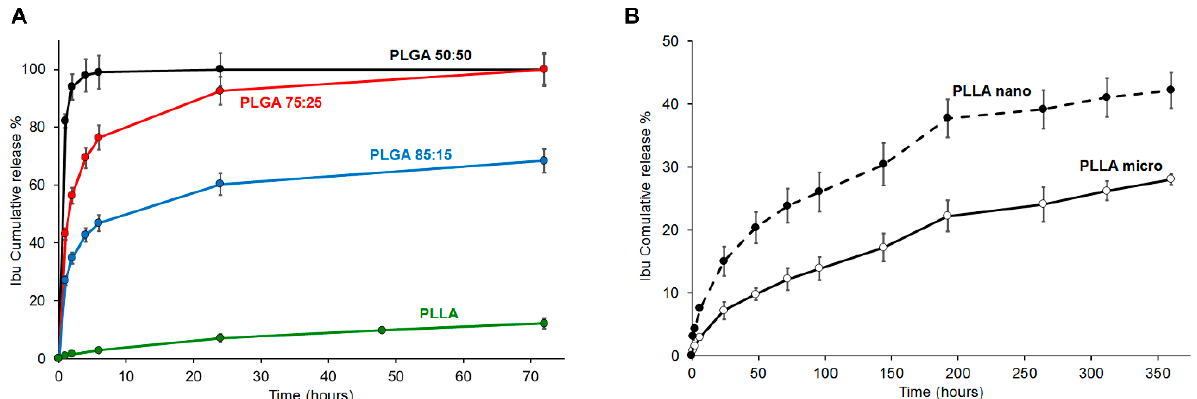
Figure 4. ( A ) Ibu release from scaffolds of different materials with similar fiber diameters: PLGA 50:50 (black), PLGA 75:25 (red), PLGA 85:15 (blue), and PLLA (green); ( B ) Ibu release from PLLA fibers with either micrometric (solid line) or nanometric (dot line) diameters.